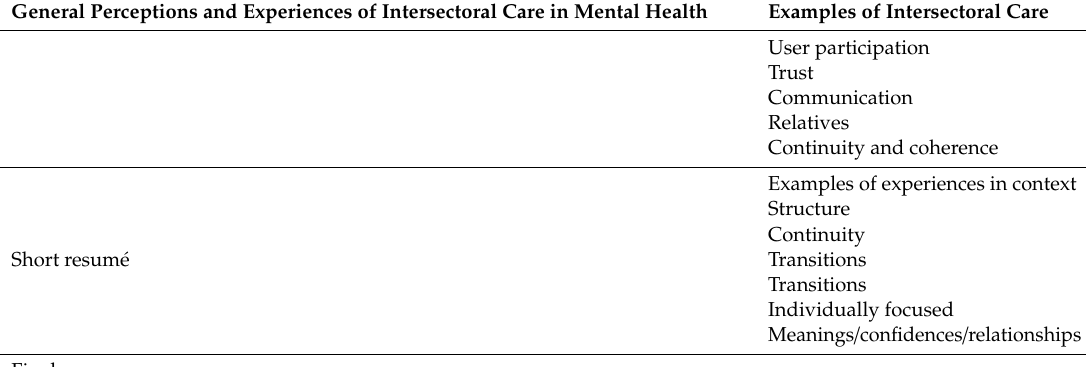
Table 2. Taboo Topics.